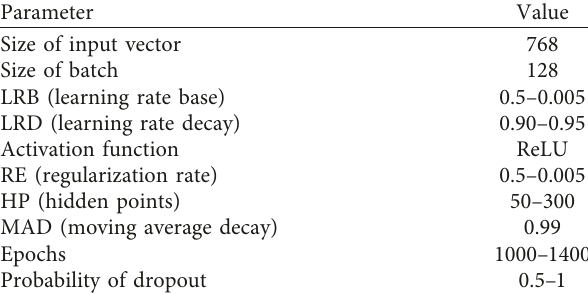
Figure 7: Format of input data. Table 2: Experiment